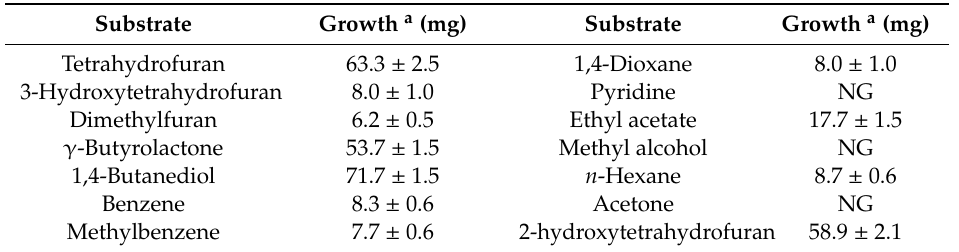
Table 1. Growth of strain ZM01 on di ff erent